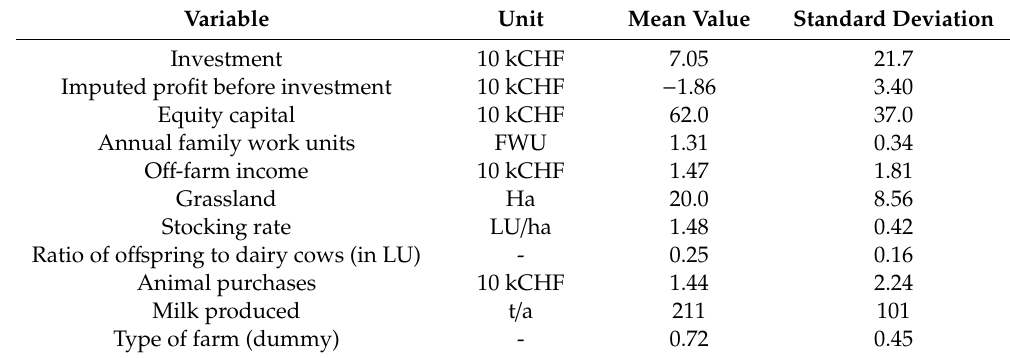
Table 1. Overview of the independent variables used, with abbreviations and